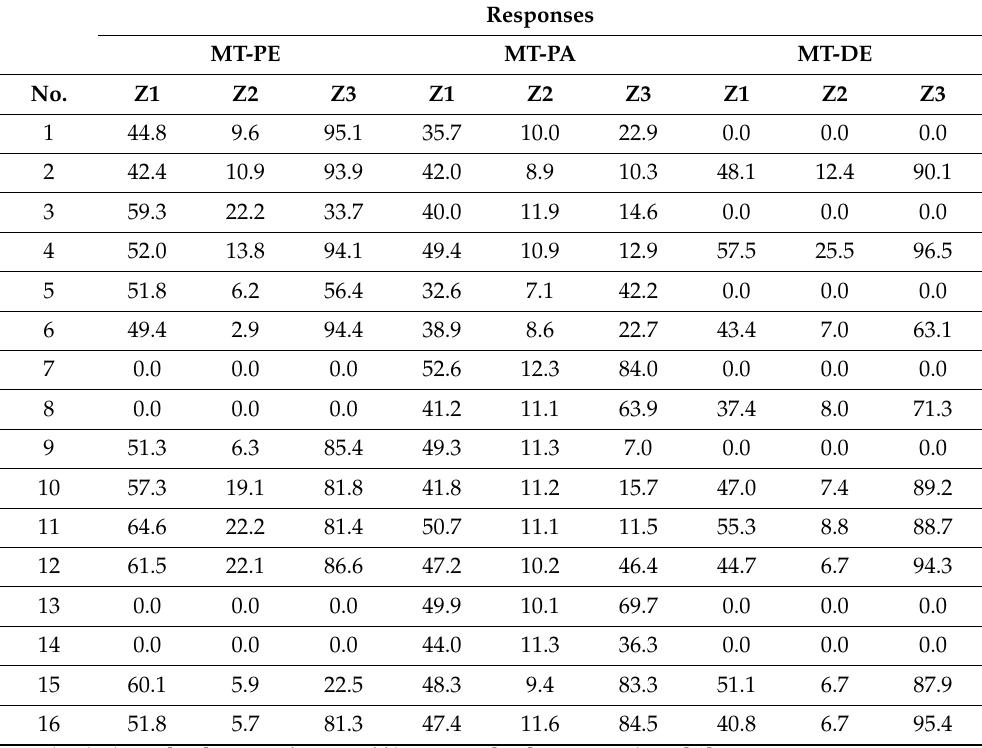
Table 4. The response values of full factorial design (16